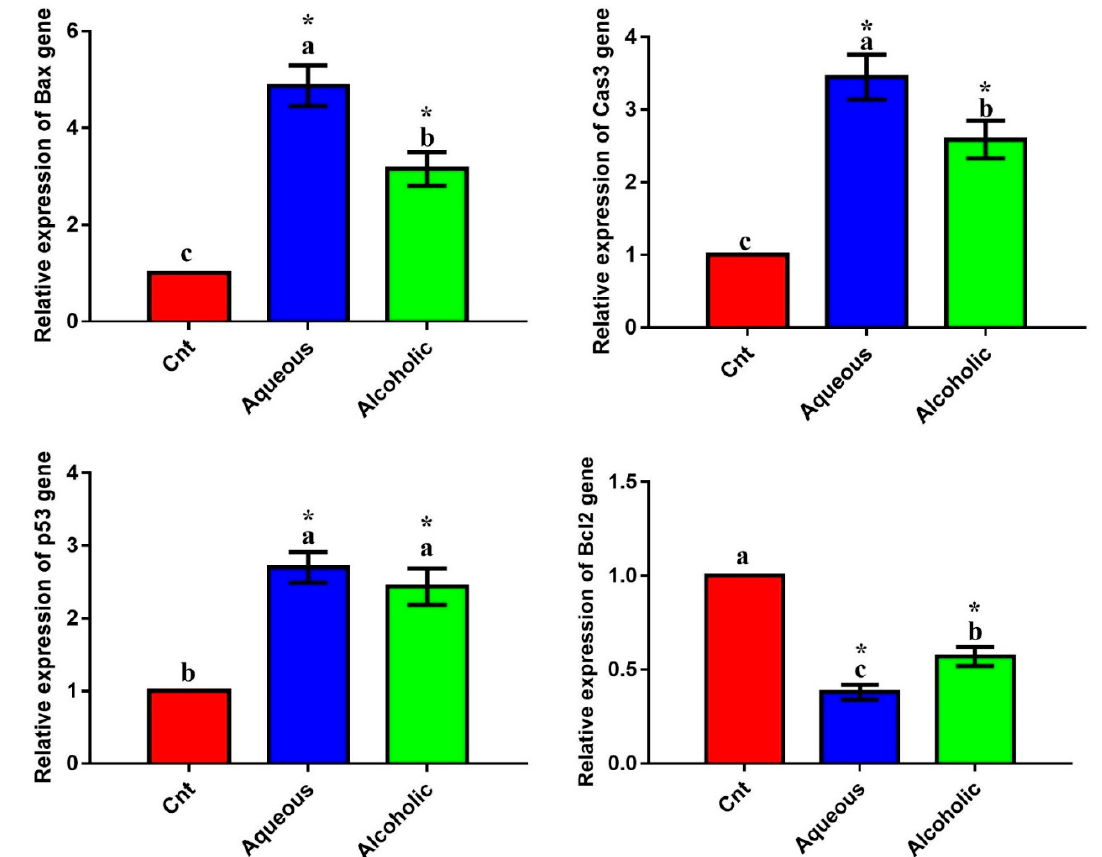
Figure 4. Expression of Bax , caspase3 ( Cas3 ), p53 , and Bcl2 genes in MCF7 cells following treatment with 5% aqueous and alcoholic larval extracts as detected by qPCR. Data were normalized to the housekeeping gene ( GAPDH ) and are expressed as the mean fold change ± SEM. Samples were run in triplicate in three independent experiments, n = 5. Groups with different letters are significantly different at p < 0.05. * indicates high significance with respect to control ( p < 0.001).